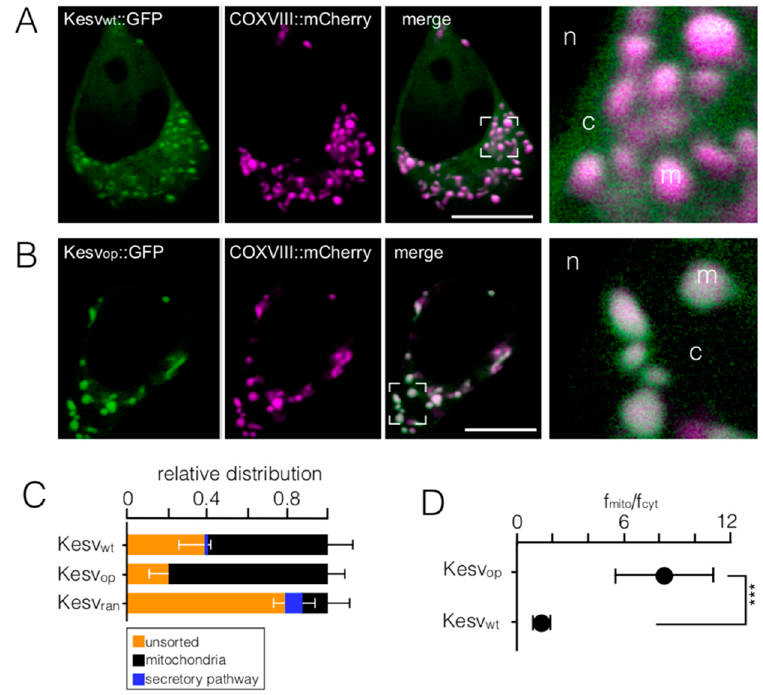
Figure 1. Codon optimization affects the sorting pattern of the Kesv channel. ( A , B ) Fluorescent images of HEK293 cells transfected with either Kesv wt ( A ) or Kesv op ( B ). Images show: GFP tagged channels (green, first column), fluorescence from mitochondrial marker (COXVIII::mCherry) (magenta, second column) and merging of magenta and green channels (third column). A magnification from areas marked in overlay images is shown in the fourth column. Letters in the images refer to cytosol (c), nucleus (n) and mitochondria (m). ( C ) Mean relative distribution (± SD; n ≥ 3) for localization of channels in mitochondria (black), secretory pathway (blue) or unsorted (orange) in HEK293 cells transfected with Kesv wt (n = 259 cells), Kesv op (n = 245 cells) or Kesv ran (n = 120 cells). ( D ) Mean ratio ± SD of fluorescence intensity in mitochondria versus adjacent cytosol (f mito /f cyt ) in cells transfected with Kesv wt or Kesv op . A Student t-test predicts high statistical significance between the two conditions ( p < 0.0001). Scale bars 10 μ m.